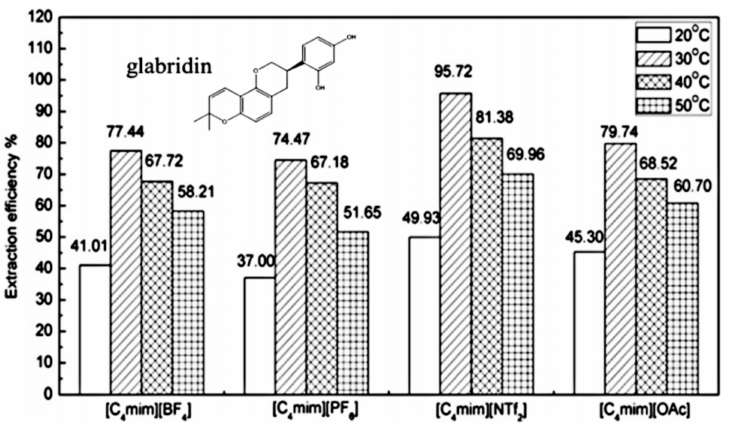
Figure 6. Effect of IL anions on extraction efficiency for glabridin [61]. Reprinted with permission of